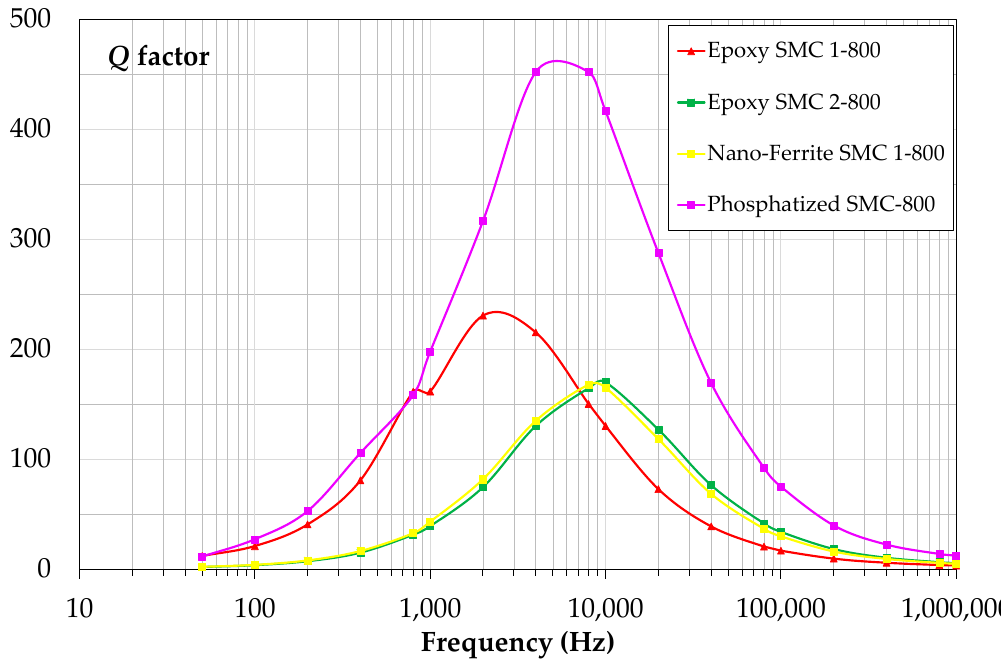
Figure 16. The Q factor of the rod samples of proposed SMC materials .